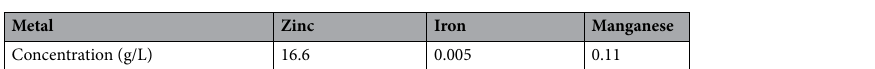
Table 8. Zinc, iron, and manganese concentrations in final electrolyte obtained from stripping